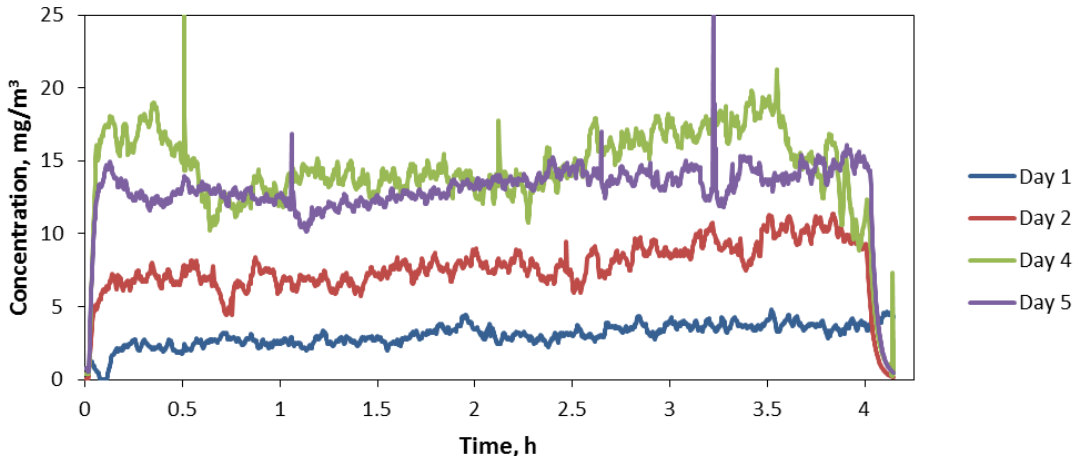
Figure 4. Aerosol concentration time series during mouse exposure days (excluding Day 3).